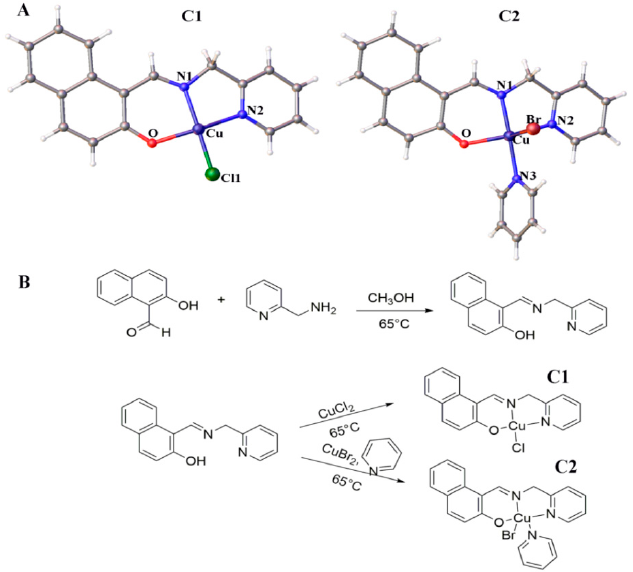
Figure 1. ( A ) Chemical structures of Cu 2+ compounds. ( B ) Synthetic routes of Cu 2+ compounds ( C1 and C2 ). Original: The Table 1 should be replaced with the following version: Table 1. Crystal data of the Cu (II) complexes ( C1 and C2 ).